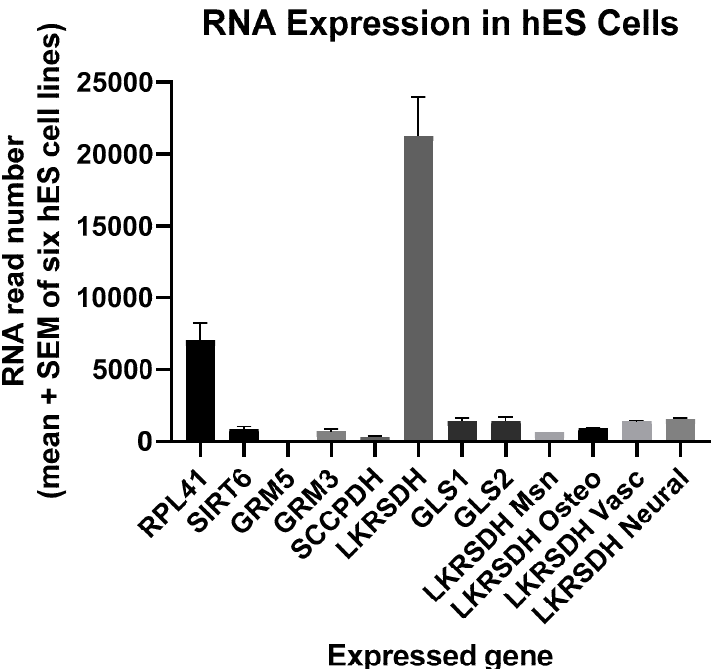
Figure 1. The mean RNA read number for alpha-aminoadipic semialdehyde synthase (LKRSDH) in human embryonic stem (hES) cells far exceeded other read numbers examined, but such was the case only before hES cells differentiated into mesenchymal (Msn), osteogenic (Osteo), vascular (Vasc), or neural cells (microarray plus RNASeq data, n = 2–6 per group, ANOVA, p < 0.0001). All mean read numbers were statistically significant and greater than zero ( p = 0.02 or less for each of the mean read numbers). RPL41, 60S ribosomal protein L41; SIRT6, sirtuin 6 (stress-responsive protein deacetylase and mono-ADP ribosyltransferase); GRM5, glutamate metabotropic receptor 5; GRM3, glutamate metabotropic receptor 3; SCCPDH, saccharopine dehydrogenase (putative);